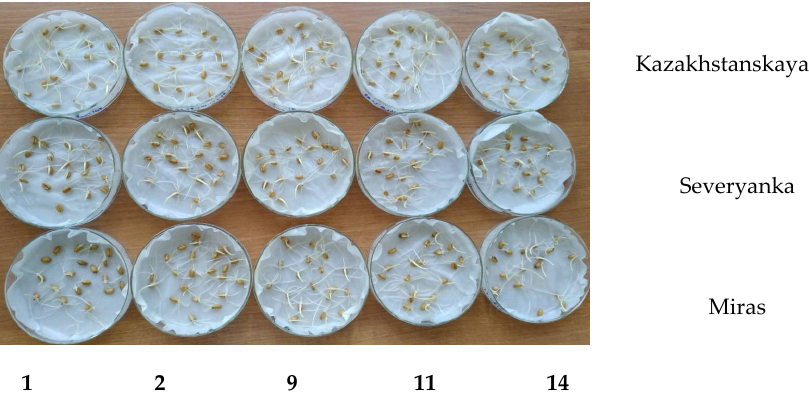
Figure 2. Two-day-old wheat seedlings with pre-sowing treatment with samples 1, 2, 9, 11, and 14.